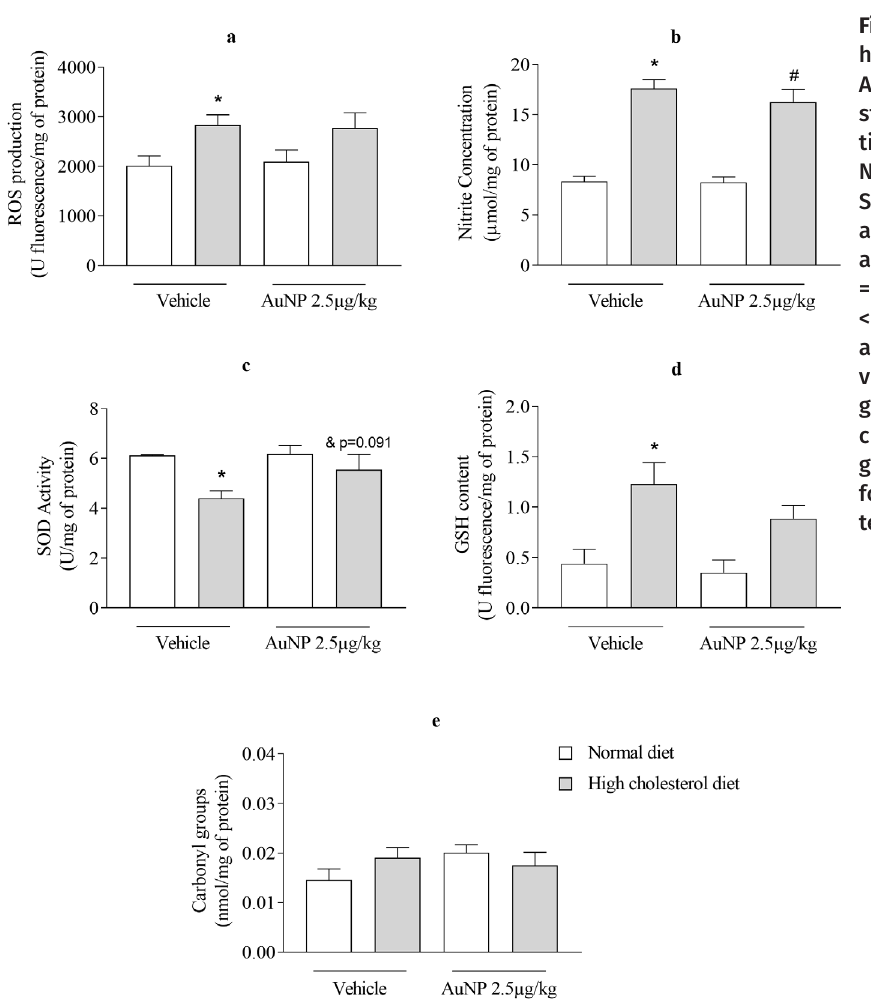
Figure 2. Effects of hypercholesterolemia